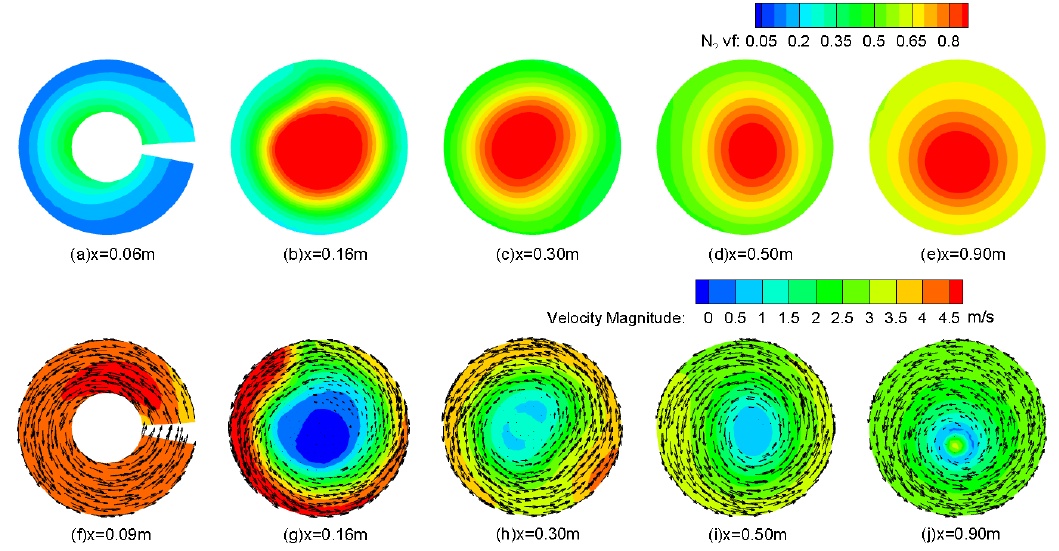
Figure 9. The N 2 volume fraction and velocity distributions of cross sections at five X ‐ positions with the spiral spoiler (Case 3 series). the spiral spoiler (Case 3